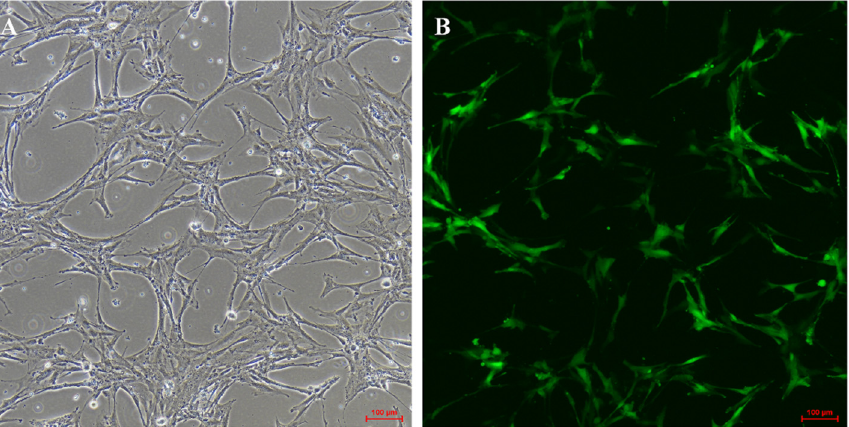
Figure 8. The YTO2 Cells transfected with pHBAd-BHG-EGFP adenovirus. At approximately 72 h after viruse infection, the EGFP expression was observed and taken images. ( A ) Bright field of transfected cells, 100 μ m. ( B ). Fluorescent (green) image of pHBAd-BHG-EGFP infected cells. Scale bar, 100 μ m.